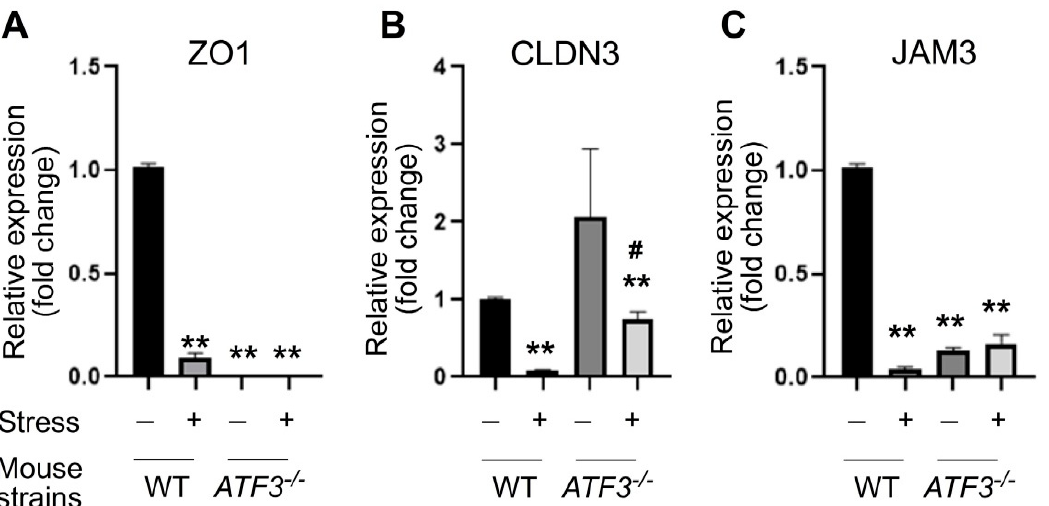
Figure 6. Relative duodenal mRNA expression levels of tight junction genes in WT and ATF3 − / − mice. Through a qRT-PCR analysis, the relative mRNA expression levels of tight junction genes ZO-1 ( A ), CLDN3 ( B ), and JAM3 ( C ) of the mouse duodenum with or without 9 h of restraint stress. The mRNA expression levels of the control (no stress; stress-) groups were normalized to 1-fold. n = 3 (2 experiments with a total of 3 mice per group). Error bars show the standard deviation; ** p < 0.01 vs. the respective no stress WT control groups and # p < 0.05 vs. the respective no stress ATF3 − / − control groups. The “stress − “ indicates no stress control groups and the “stress +” indicates the stressed groups.